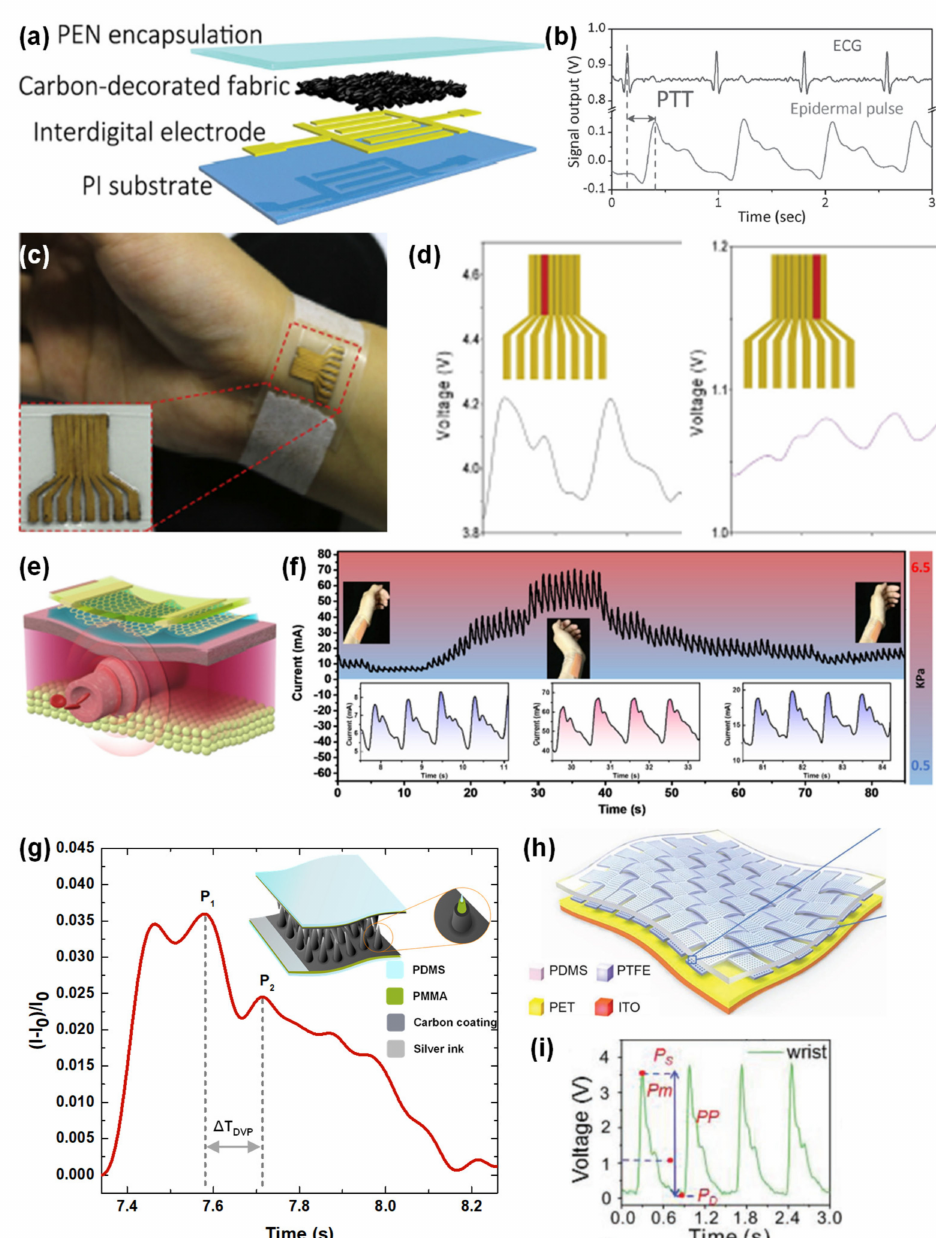
Figure 11. E-skins applied to blood pressure and blood pressure wave detection. ( a ) E-skin developed by Ni Zhao and co-workers in 2016 [32] (Copyright © 2020 WILEY-VCH Verlag GmbH & Co. KGaA, Weinheim, Germany). ( b ) Electrocardiogram signal and epidermal pulse signals from the sensor in (a), with identification of the PTT [32] (Copyright © 2020 WILEY-VCH Verlag GmbH & Co. KGaA, Weinheim, Germany). ( c ) E-skin developed by Yao-Joe Yang and co-workers in 2018, attached to